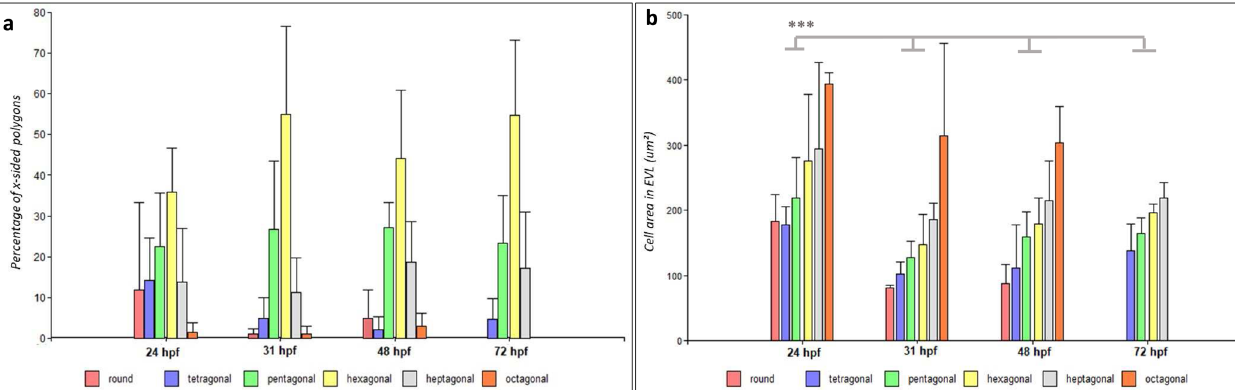
Figure 3. Polygon class distribution in the EVL layer from 24 to 72 hpf. a ) Bar graph displaying mean percentages of x-sided polygons of embryos at 24 hpf (n = 81 cells), 31 hpf (n = 147 cells), 48 hpf (n = 133 cells) and 72 hpf (n = 102 cells). Hexagonal and pentagonal cells are the main cell morphologies observed in the EVL. b ) Mean area of cell types on EVL at 24 hpf (EVL n = 73), 31 hpf (EVL n = 147), 48 hpf (EVL n = 133) and 72 hpf (EVL n= 102). Significant differences were found in the mean cell area for penta and hexagonal cells between stages (***p < 0.001). Data obtained from 30 3D-ROIs in five animals for each stage. The bars represent mean values ± standard deviations